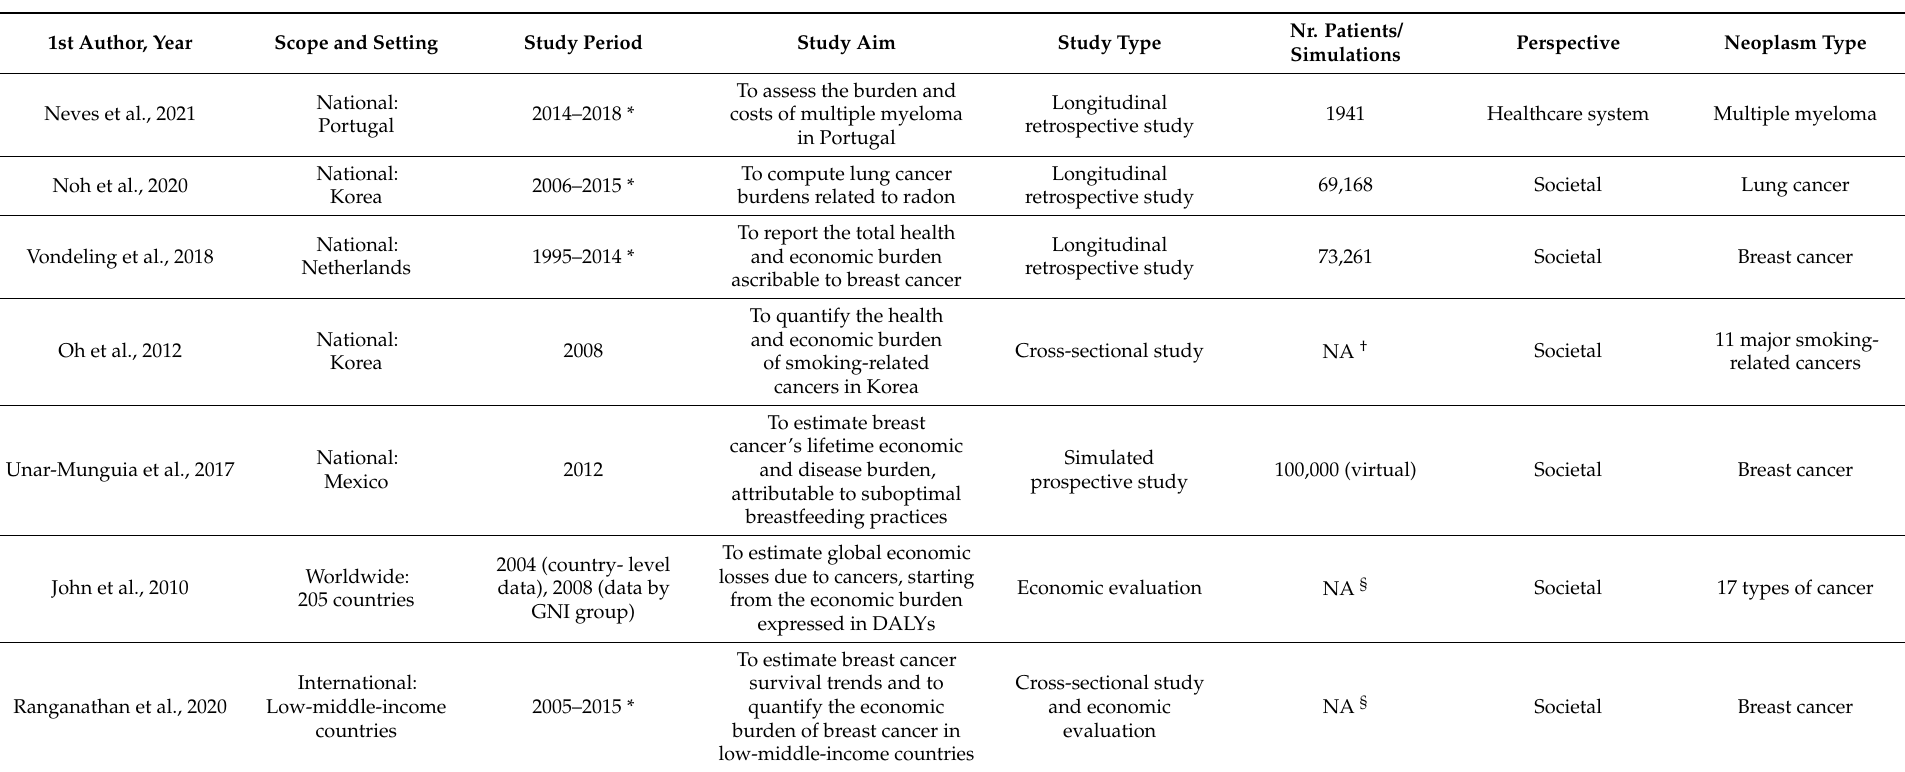
Table 1. The descriptive characteristics of included studies: the general characteristics of included studies. White rows indicate studies performing separate economic analyses related to costs and DALYs (included in the quantitative synthesis), whereas shaded rows contain studies that deduce costs starting from DALYs (not included in the